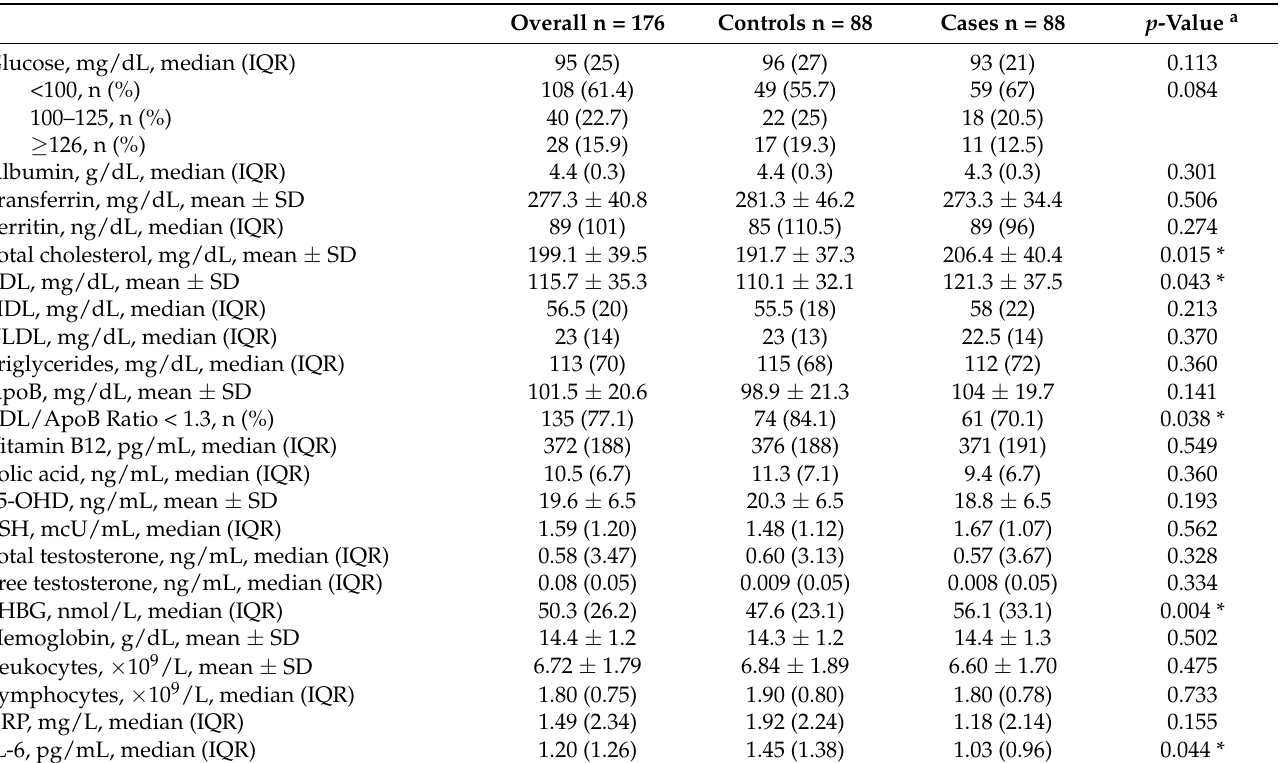
Table 2. Laboratory